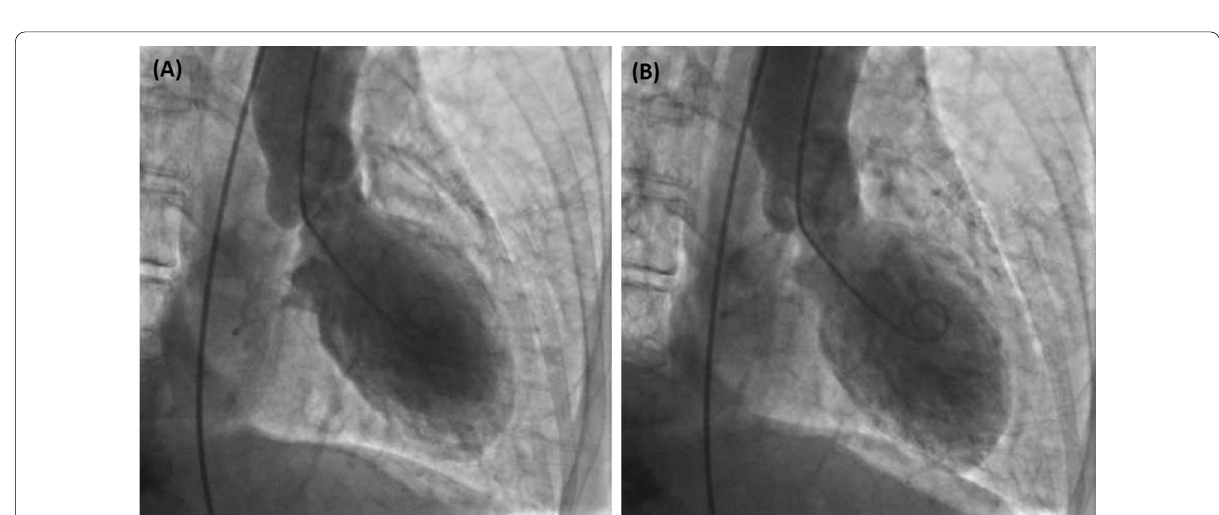
Fig. 2 Left ventricular angiography in A diastole and B systole demonstrating akinesis of anterior wall, apex, and inferior wall in setting of non-obstructive coronary artery